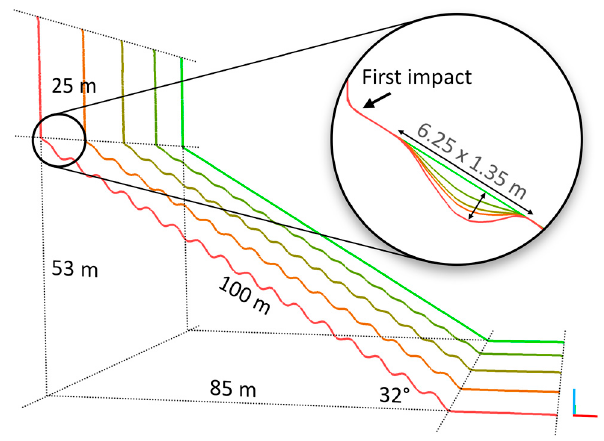
Figure 16. Profile of the five artificial slopes with different roughnesses. The undulations only begin after 2 m horizontally to ensure that the first impact has the same geometry. The vertical part of the profile was not considered for the simulation; it is only shown here to demonstrate the freefalling height preceding the first impact. The XZ plane space is parallel to the trihedron respective red–blue axes.